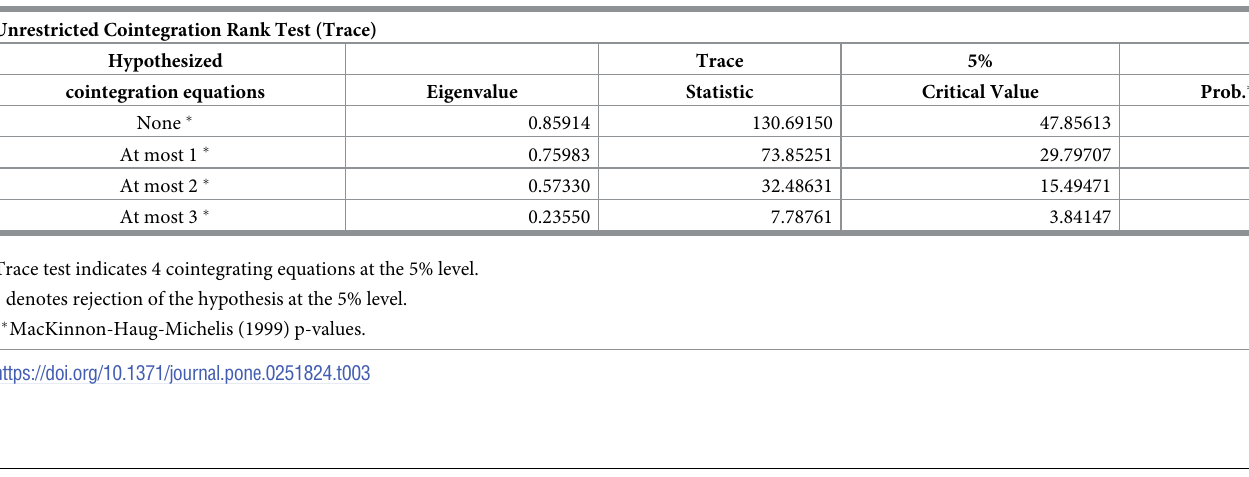
or it may be due to the fact that economic growth drives energy consumption. (VAR) method, vector error correction (VEC) model can distinguish the long-term relation- ship and short-term relationship between variables, and can identify the source of causality that cannot be detected by the usual Granger causality test. Therefore, vector error correction (VEC) model can be established to further clarify the correlation between them. In Table 3, we know that the lag order is 4. Therefore, in the VEC model, the lag order is set to 4, and the cointegration relation equation number is 3. So as to obtain the VEC cointegration relation equations of the time series, as shown in Table 4. The following results are obtained through Eviews10 software. Table 4 shows the cointegration relationship with the largest log likelihood value, which is also the cointegration relationship regression in VEC. According to Table 4, the cointegration equation of this paper can be written as: